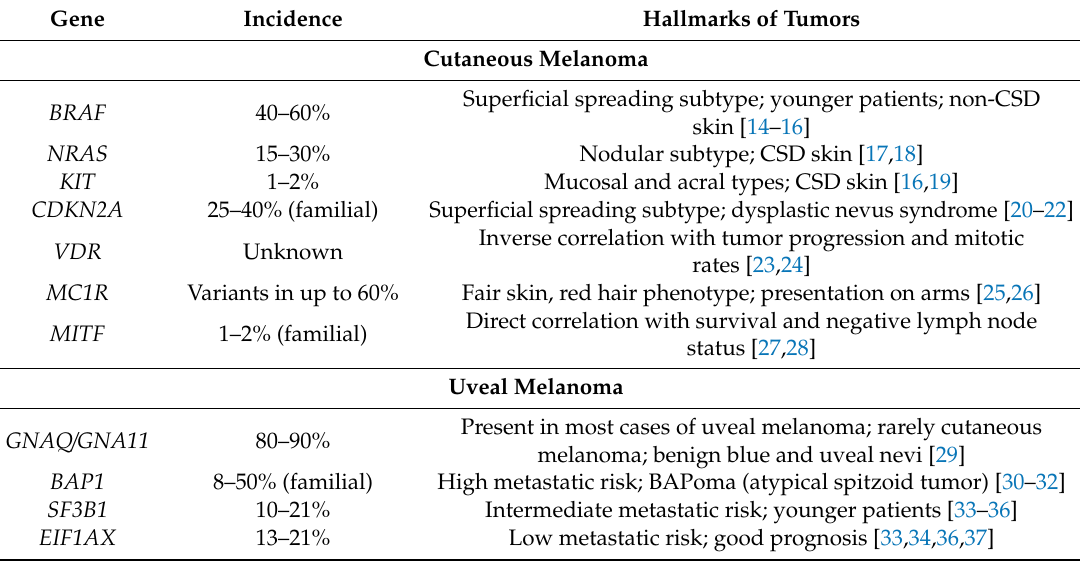
Table 1. Summary of melanoma mutations.